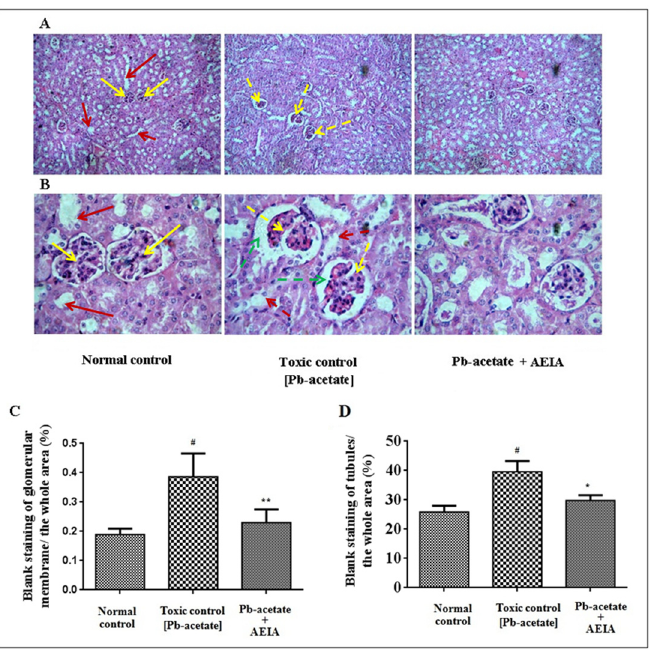
Fig 8. Histological sections 100 x (A) and 400 x (B) of kidneys of experimental mice in absence (Pb- acetate) and presence of AEIA (Pb-acetate + AEIA). Untreated mice were kept as normal control to compare the structural changes caused by Pb-acetate. Yellow and red arrows represent normal glomerulus structure and renal tubules, respectively; dotted arrows represent the Pb-acetate mediated glomerular hypercellularity (yellow) and capsular space thickening (green), and cloudy appearance of renal tubules (red). C. The widening of capsular space was represented as percentage of the blank area relative to the whole area of the photomicrograph (400 x, randomly selected areas containing one glomerulus were chosen). D. The dilation of renal tubules was represented as percentage of the blank area relative to the whole area of the photomicrograph (100 x, randomly selected areas devoid of any glomerulus were selected). Values are expressed as mean ± SE, (n = 60). # Values differ significantly from normal control (p < 0.01). * Values significantly differed from Pb-acetate control (P <